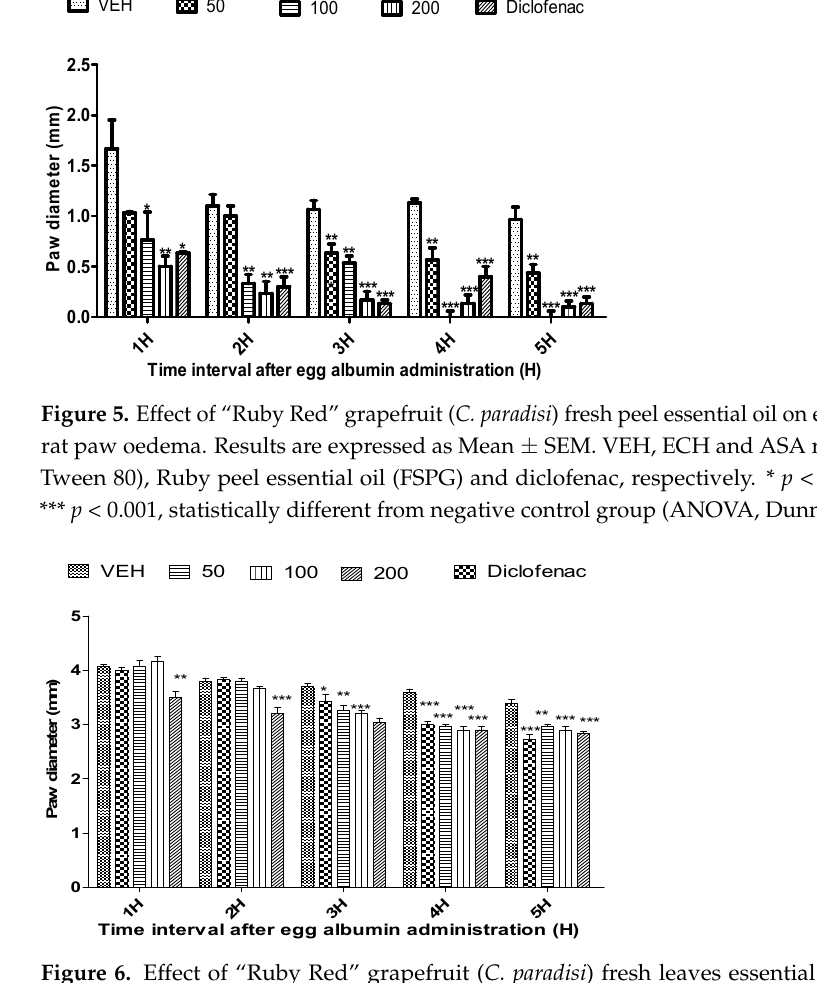
Figure 6. Effect of “Ruby Red” grapefruit ( C. paradisi ) fresh leaves essential oil on egg albumin- induced rat paw oedema. Results are expressed as Mean ± SEM. VEH, ECH and ASA represent vehicle (5% Tween 80), Ruby leaves essential oil (FSLG) and diclofenac, respectively. * p < 0.05, ** p < 0.01 and *** p < 0.001, statistically different from negative control group (ANOVA, Dunnett’s).